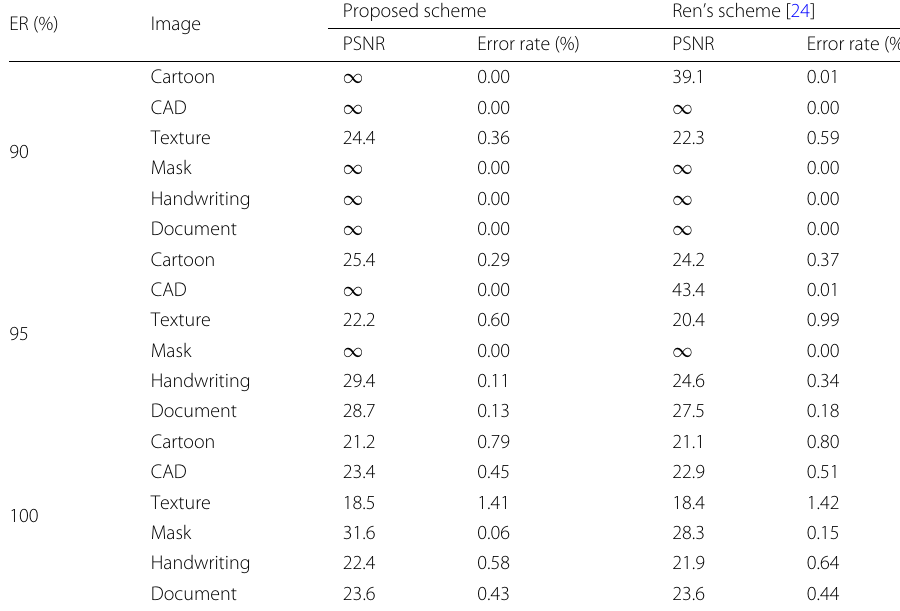
Table 1 Comparison PSNR and pixel error rate with the same embedding rate (ER). In this experiment, the proposed scheme and Ren’s scheme are tested Proposed scheme Ren’s scheme [24] ER (%) Image PSNR Error rate (%)